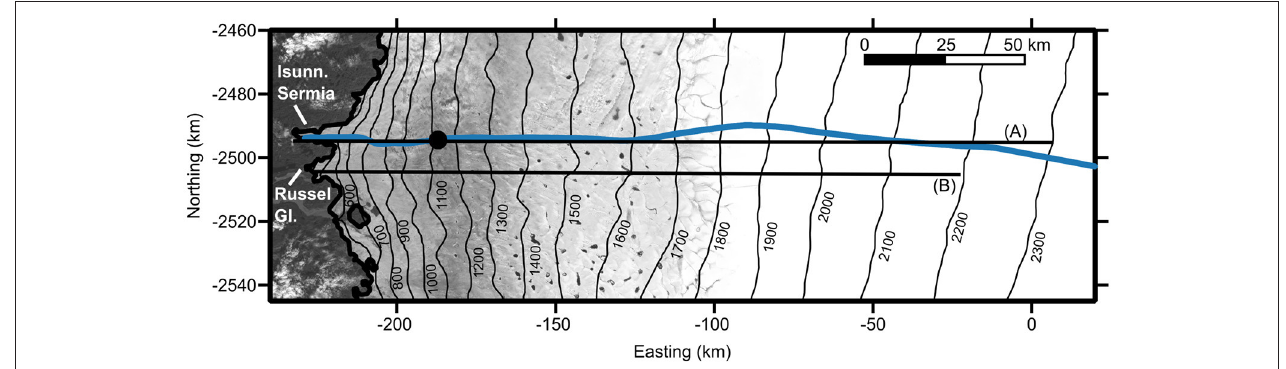
FIGURE 2 | Study area. Surface elevation contours come from CryoSat-2 (Helm et al., 2014), and are overlain on a Landsat 8 image from July, 2015. Blue line locates the flow line used in Figure 8 . Black dot locates the borehole yielding temperature data. Black lines identify the IceBridge transects presented in Figure 3 .